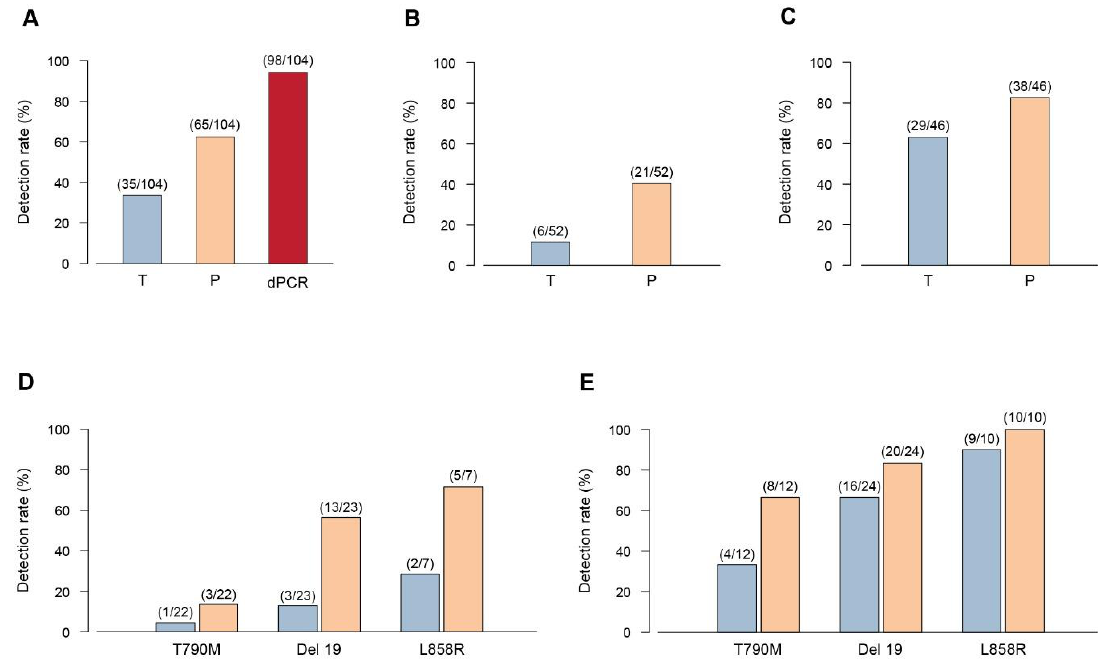
Figure 3. Detection rate of three platforms in plasma EGFR mutations detection. The detection rate is shown as the frequency of sample that resulted positive when tested in liquid biopsy with the three different methods: Scorpion-ARMS EGFR Plasma RGQ PCR Kit-QIAGEN (T), PNAClamp EGFR - PANAGENE (P), and QuantStudio 3D Digital PCR System-Thermo Fisher Scientific (dPCR). ( A ) Overall detection rate of the three platforms. ( B ) Overall detection rate of the Scorpion-ARMS compared to the PNAClamp for the low copy (<1 copy/µl) patient group as measured by Digital PCR. ( C ) Overall detection rate of Scorpion-ARMS compared to PNAClamp for the high copy (>1 copy/µl) patient group as measured by Digital PCR. ( D ) Comparison of Scorpion-ARMS (blue) with PNAClamp (orange) for the low copy (<1 copy/µl) patient group as measured by Digital PCR, considered separately for each EGFR main mutation (Del 19, L858R, and T790M). ( E ) Comparison of Scorpion-ARMS (blue) with PNAClamp (orange) for the high copy (>1 copy/µl) patient group, measured by Digital PCR, considered separately for each EGFR main mutation (T790M, Del 19, and L858R). Numbers in parenthesis indicate the relative amount of mutations detected with each specific method.